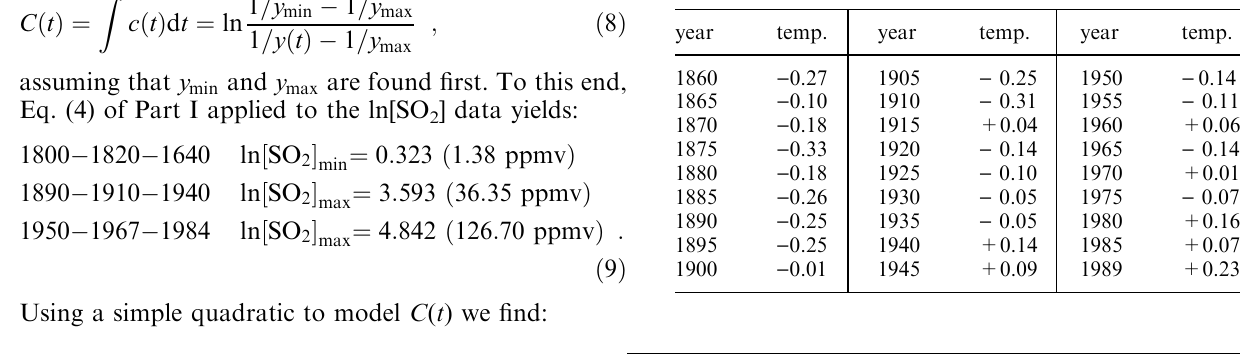
Table 3. Northern hemisphere